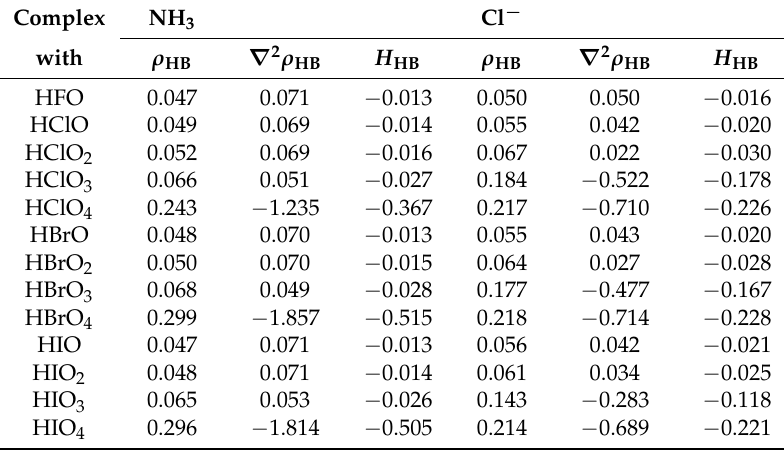
Figure 4. Molecular graphs of HB and XB complexes of HClO n :NH 3 . The bond and ring critical points are represented by green and red dots, respectively. Only bond paths are depicted. Table 5. Electron density ( ρ HB ), Laplacian ( ∇ 2 ρ HB ), and electron density total energy ( H HB ) in a.u. for the intermolecular bond critical points for HB